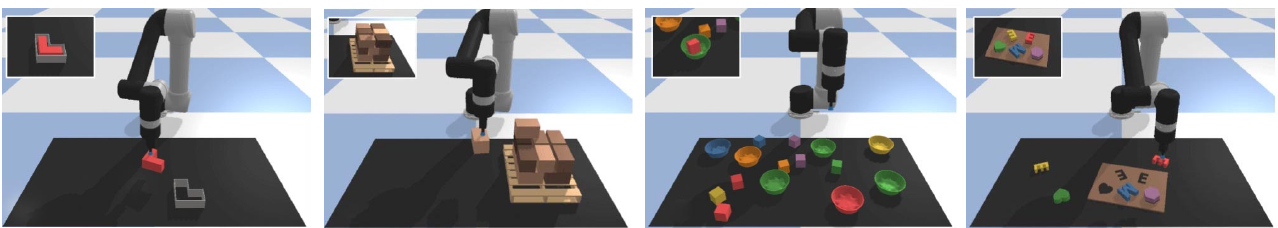
Figure 16. Examples of Ravens-10 benchmark tasks. Left to right: block insertion, palletizing boxes, place red in green, assembling